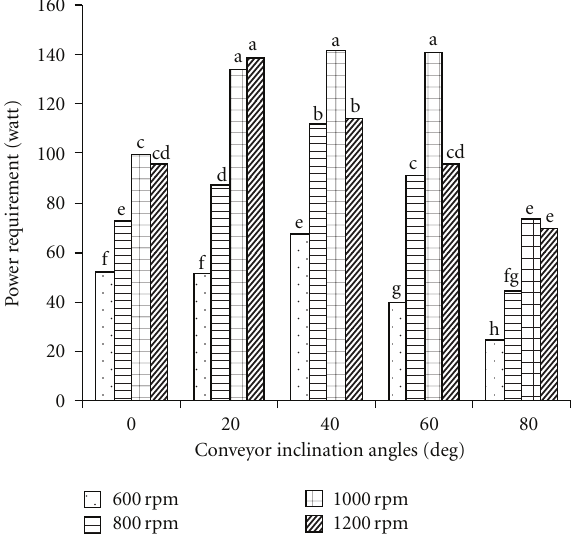
Figure 4: Mean comparison results of interaction e ff ects of inclination angle and screw rotational speed on power requirement (dissimilar letters show di ff erent significantly at probability level